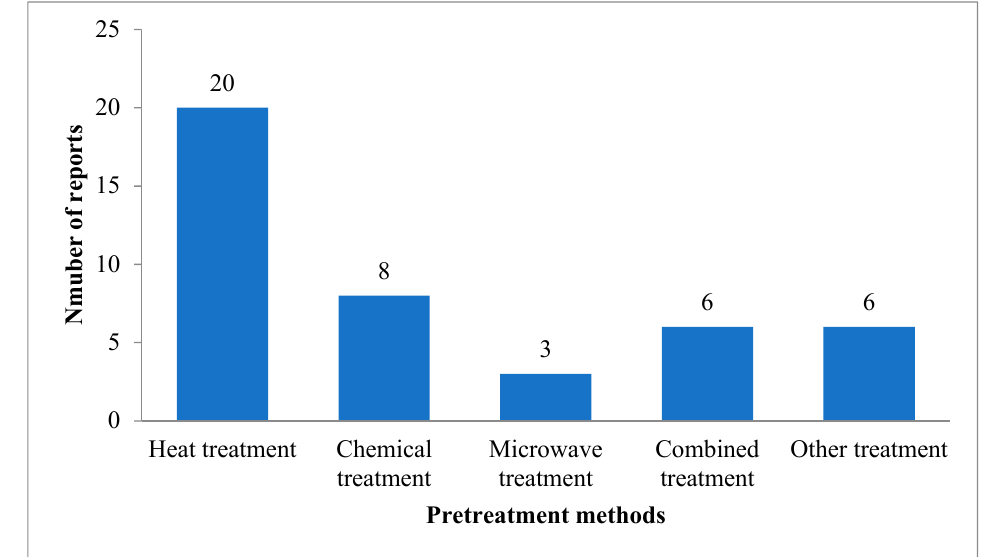
Figure 4. The frequency of top few pretreatments methods used for selection of hydrogen-producing microorganisms.